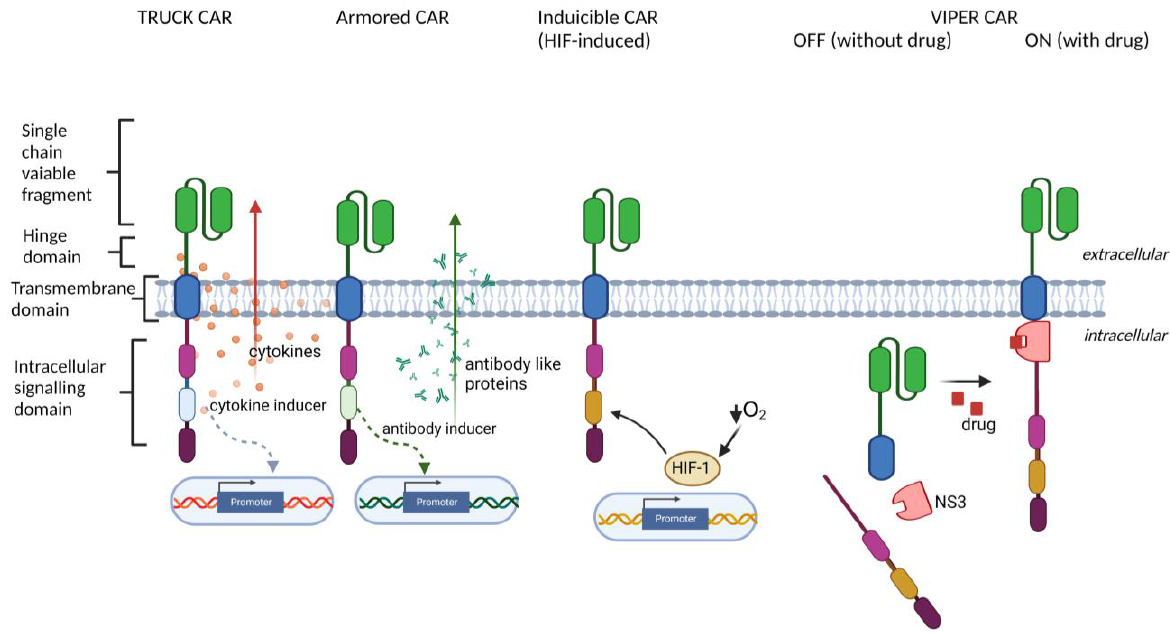
Figure 2. Schema presenting examples of the 4th generation of CAR constructs, including TRUCK CAR, Armored CAR, inducible CAR, and ON/OFF-controllable VIPER CAR.